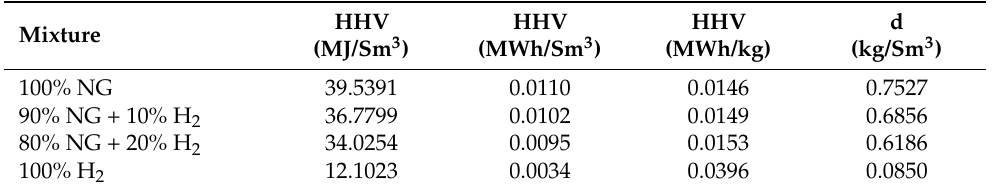
Table 1. High heating values and density of NG, pure hydrogen and H2NG mixtures with 10% and 20%vol H 2